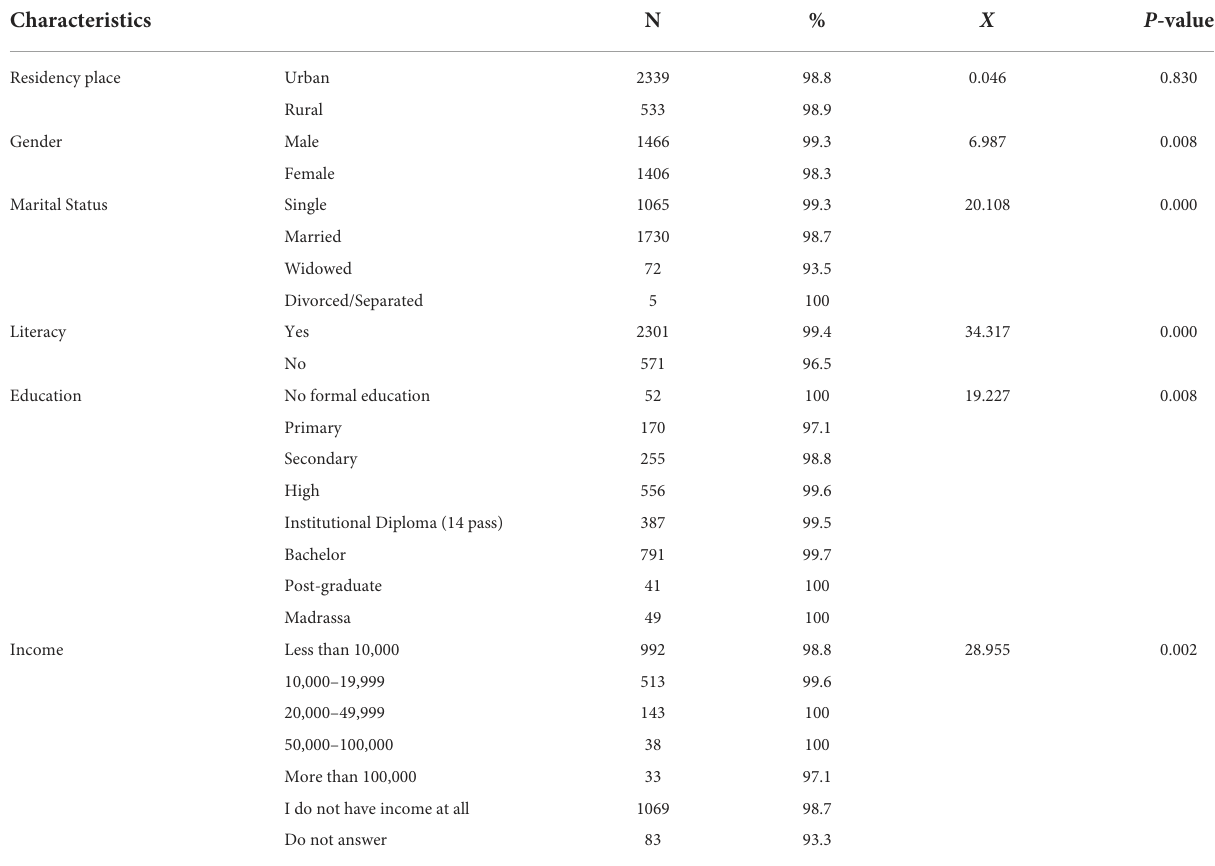
TABLE 3 Knowledge score of COVID-19 by demographic characteristics. Characteristics